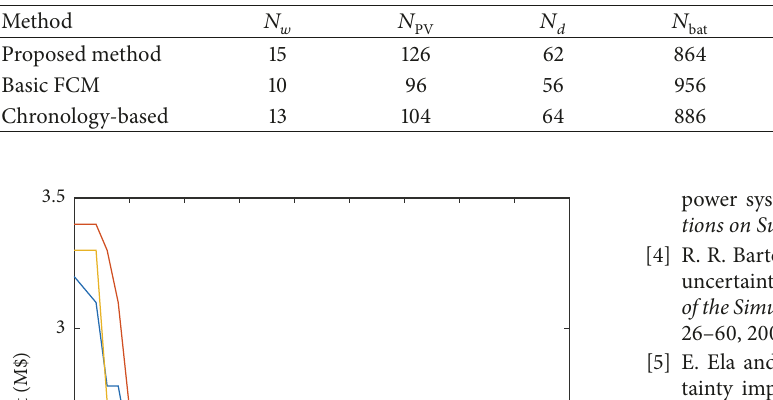
Table 4: Performance comparison.